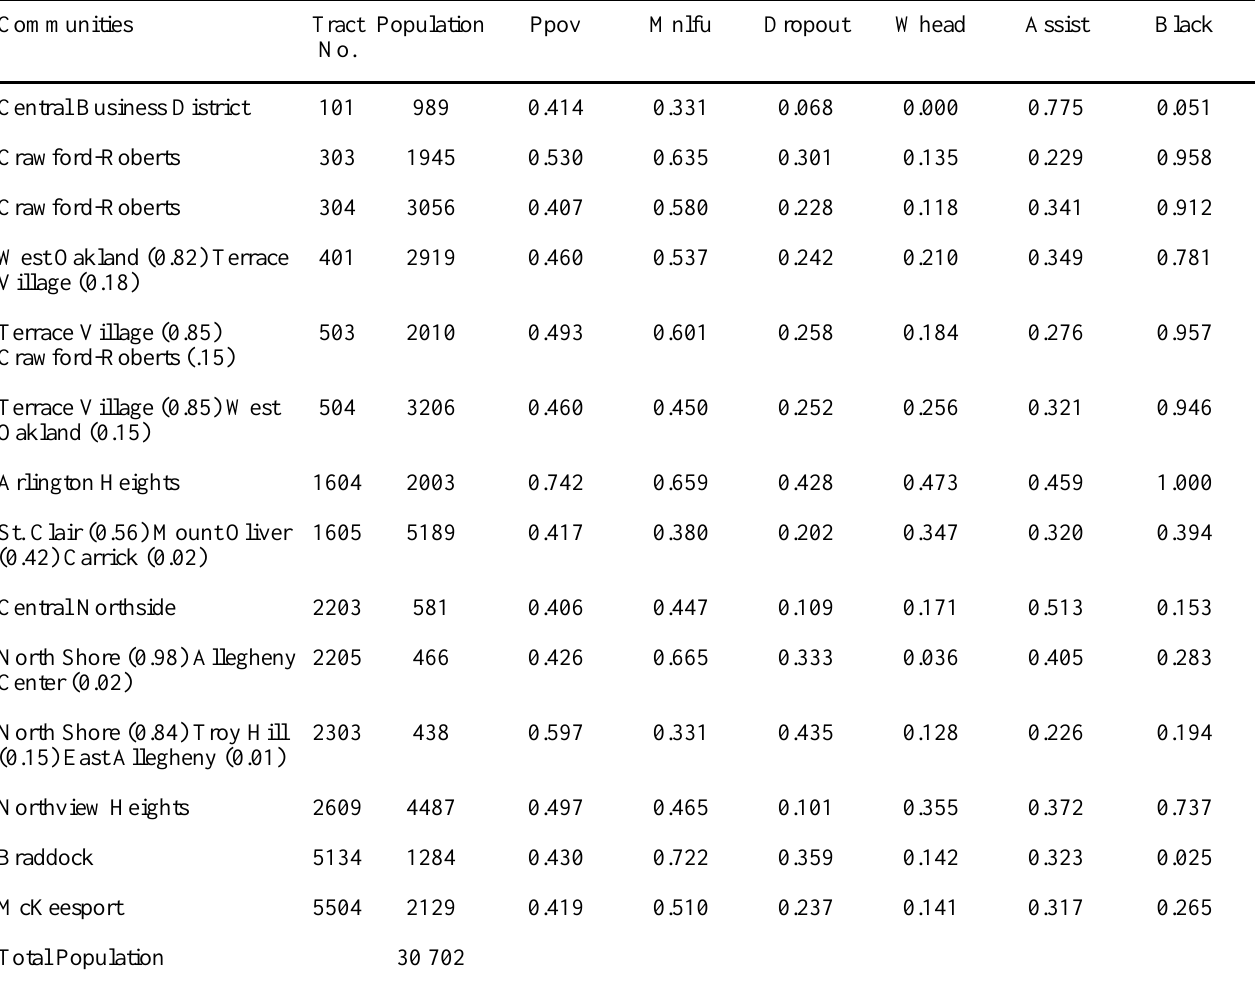
Table 8. Extreme poverty tracts in 1969, Pittsburgh Standard Metropolitan Statistical Area Communities Tract No.